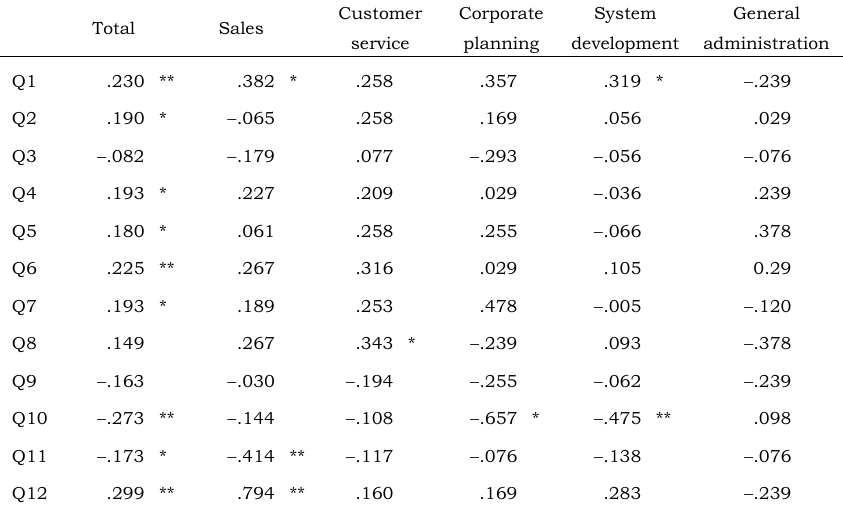
Table 3. Comparison between the first and the second surveys Total Sales